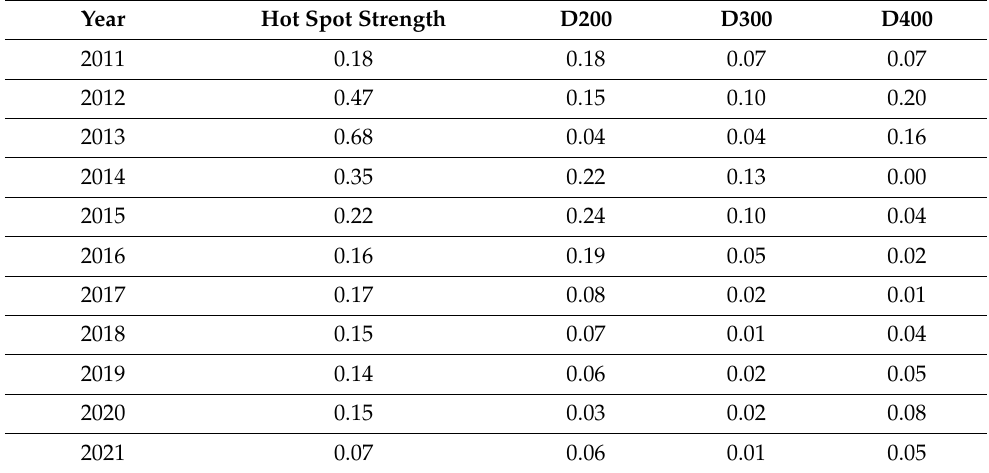
Table 2. Annual values for the percentages of areas with numbers of data points greater than 200, 300, and 400 data points per square kilometer.